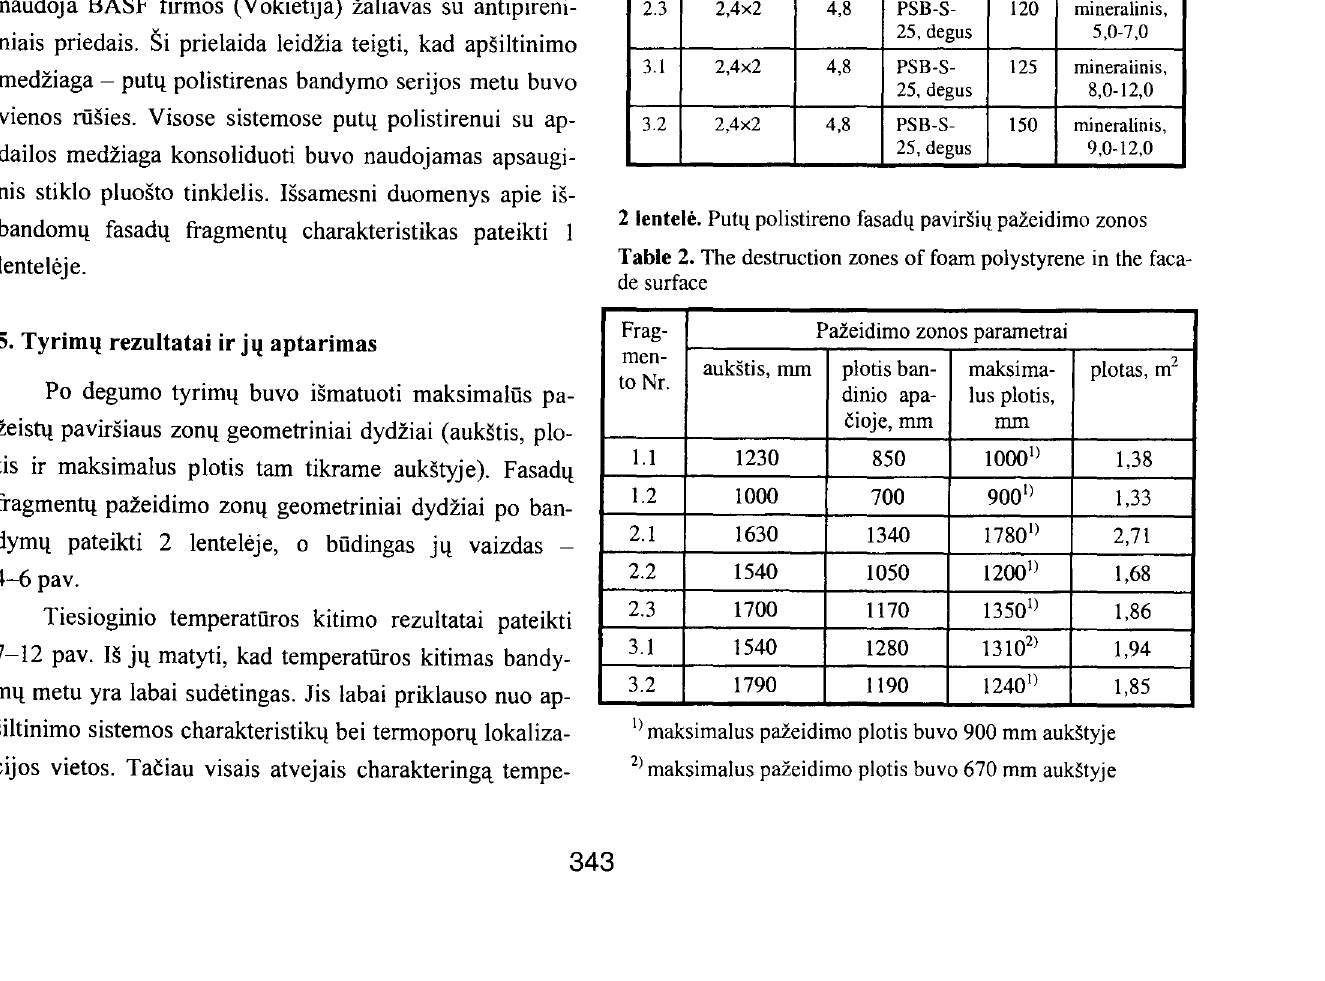
Table 2. The destruction zones of foam polystyrene in the faca de surface Frag- P3Zeidimo zonos parametrai men- aukstis, mm plotis ban- maksima- plotas, m 2 to